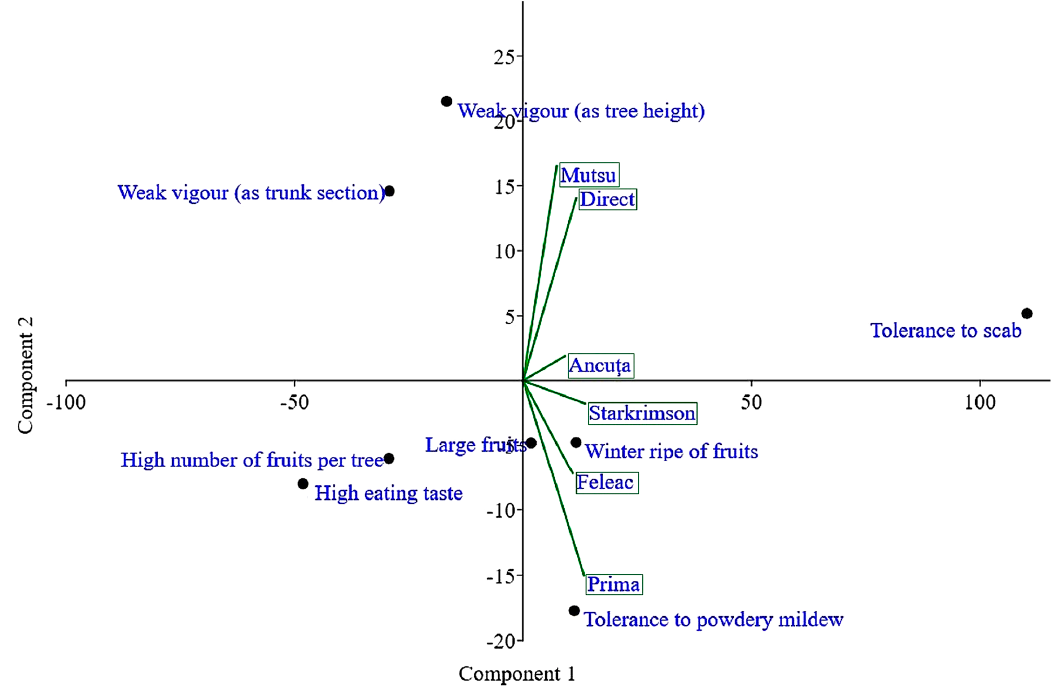
Figure 3. Principal component analysis (PCA) for the types of hybridizations performed (direct hybridizations and five testcrosses) and the traits analyzed in the F 1 hybrids. Tolerance to apple scab was the only trait that was placed in a different quadrant from the others. This trait was the most different from the others (quadrant I). In opposi ‐ tion to the adequate response of trees to apple scab attack, the main characteristics of fruit production and fruit quality appeared, namely the number of fruits per tree, large fruits, and high eating taste. On the other diagonal, in quadrant IV there was reduced tree vigor (trunk section area and tree height, both elements of tree growth that were located close) in an inverse relationship with winter ripeness of fruits and tree tolerance to powdery mildew attack. Of the two main components of the PCA, PC1 captured a very large part of the total variation (90.5%) but PC2 only a small part (6.2%). A UPGMA dendrogram (Figure 4) confirmed the distance of tolerance to apple scab attack from the rest of the analyzed characters, which was highlighted previously by PCA. The tolerance to apple scab formed as a distinct cluster a singular character that was dif ‐ ferent from the other cluster, on which there were two subclusters: one with three charac ‐ teristics and the others with four characteristics grouped by two.